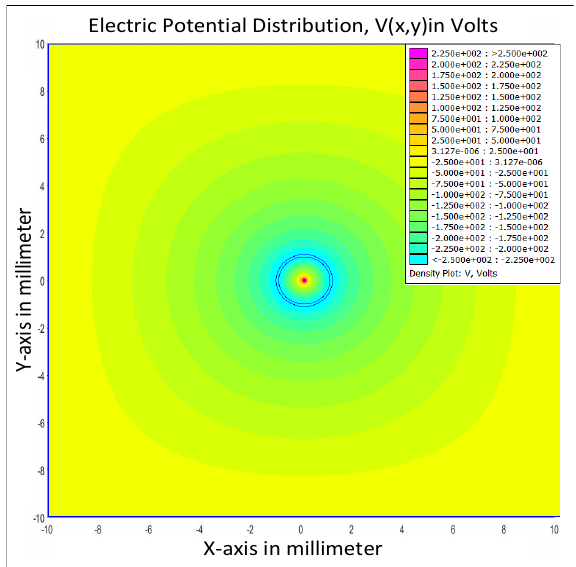
Figure 10. The electric potential distribution of the proposed device when the voltage is halved.